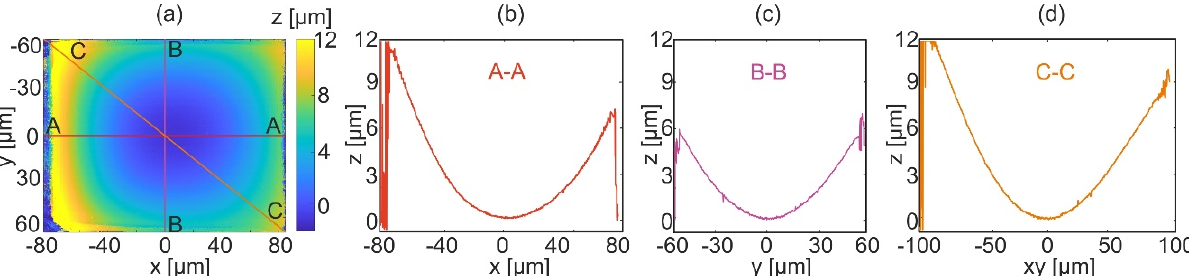
Figure 10. Results of the topography reconstruction of the micro mold with the equally angle spaced strategy: ( a ) 2D map, ( b ) horizontal cross-section (A-A), ( c ) vertical cross-section (B-B), and ( d ) diagonal cross-section (C-C).